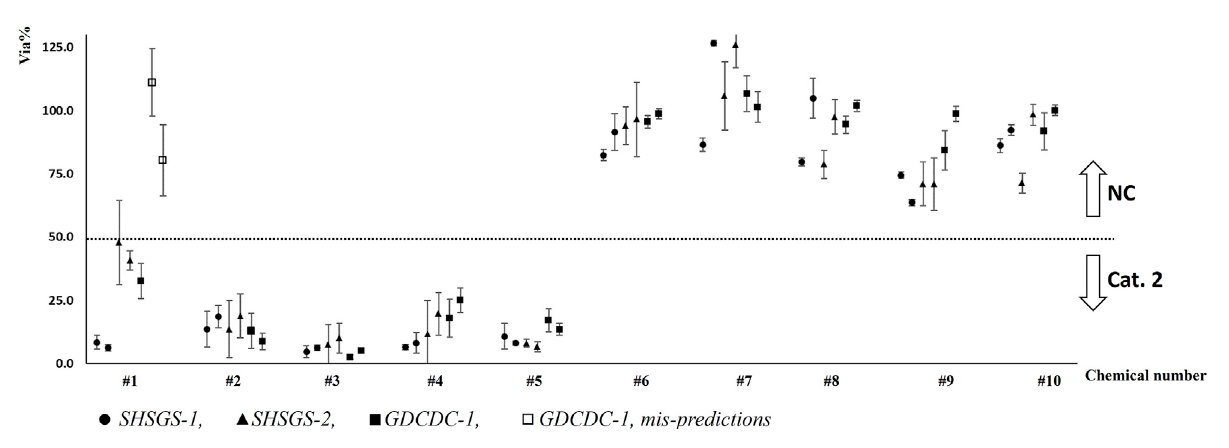
FIGURE 5 Distribution of mean cell viabilities of each quali fi ed test for 10 chemicals in two laboratories (P2).